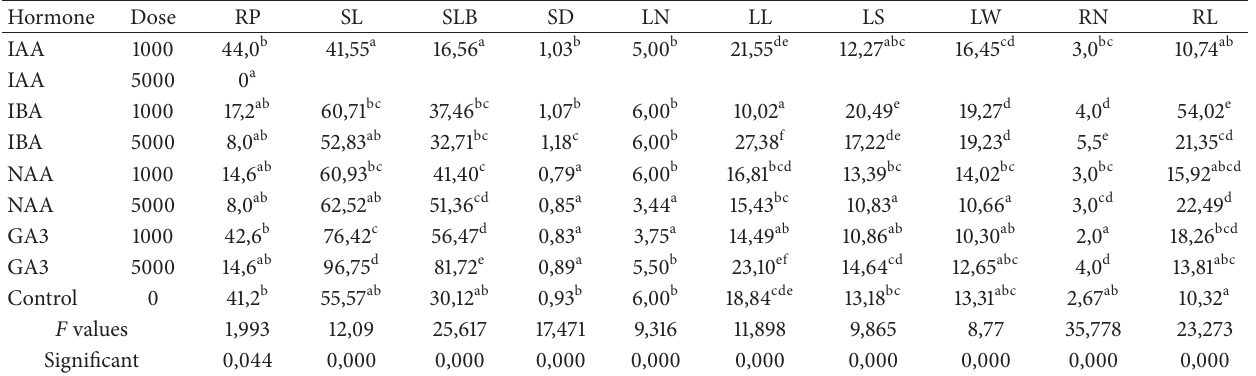
Table 1: Mean values of characters, results of variance analysis, and the Duncan